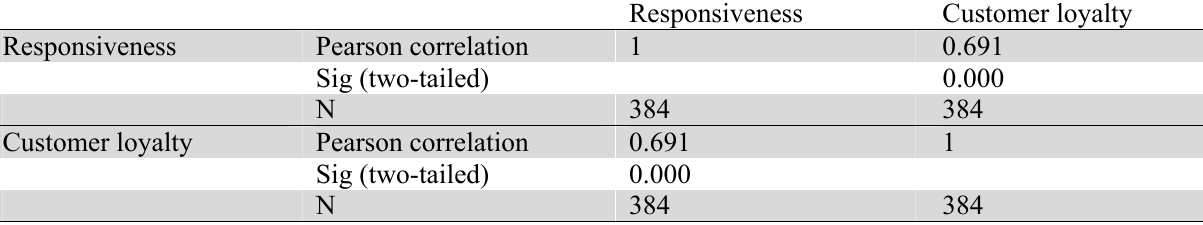
The result of Pearson correlation ratios